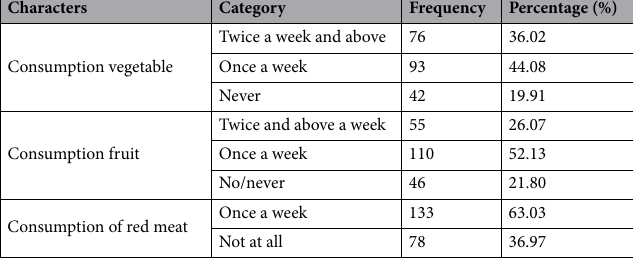
Table 2. Dietary habit-related characteristics of pregnant women in Northwest Ethiopia, 2019 (n =